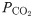
Distribution of carbonate species in CaFe0.5Mg0.5(CO3)2 system as a function of PCO2 at 373.15 K and 25 MPa.(DIC, total dissolved inorganic carbon, DIC=[CO2(aq)]+[HCO3−]+[CO32−])